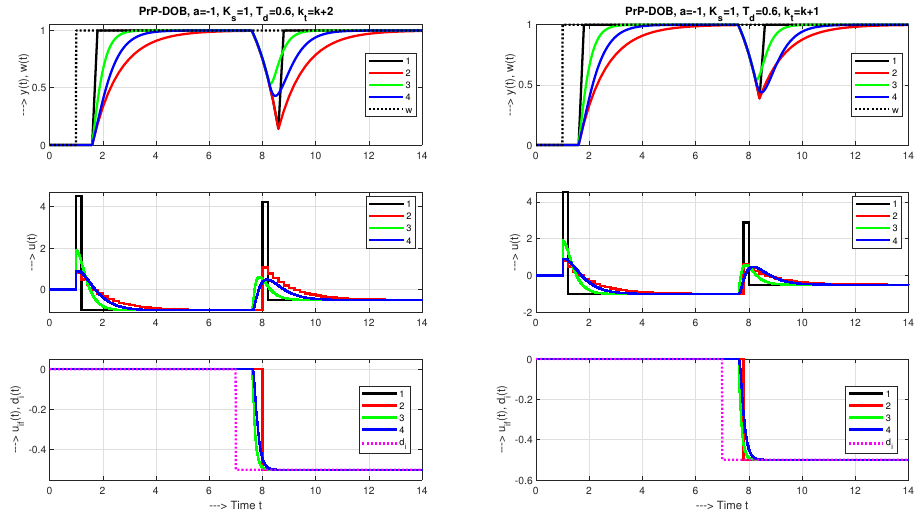
Figure 6. Time responses corresponding to different nominal tuning of the PrP-DOB controller specified in Example 1 with the controllers derived with ESO (Equation (26)) for the total delay k t = k + 2 ( left ) and by the polynomial approach (Equation (37)) with the minimal possible value k t = k + 1 ( right